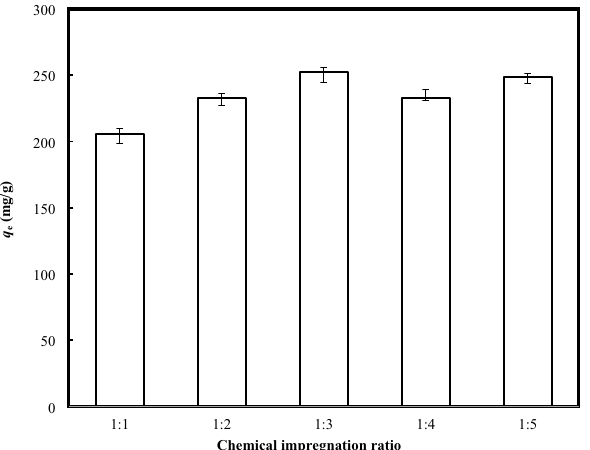
Figure 1. Effects of chemical impregnation ratio on the adsorptive uptake of MB (Adsorbent dosage = 0.2 g/200 mL; Temperature = 30 °C; Initial concentration = 500